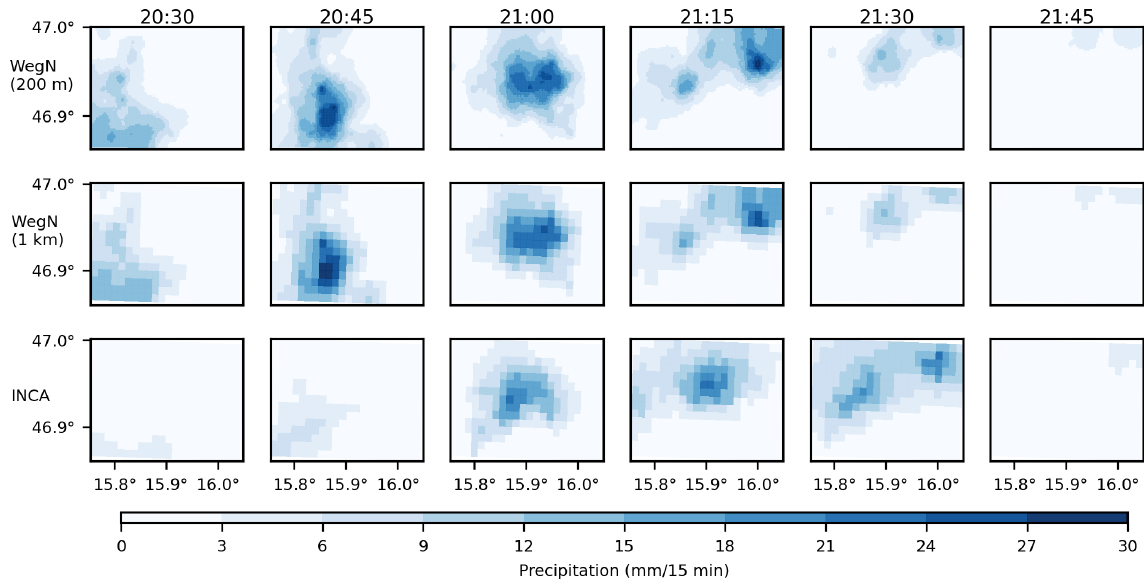
Figure 2. A convective event on 18 May 2009 that was observed by WegenerNet in original 200m resolution (top) and 1km resolution (center) and by INCA